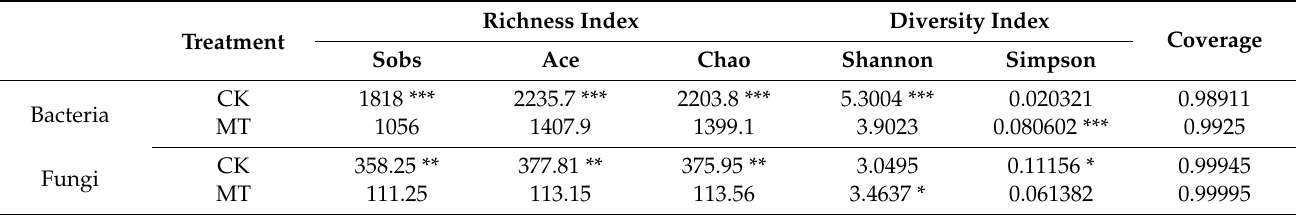
Table 1. Alpha diversity based on OTU level (Student’ t -test and FDR value). Richness Treatment